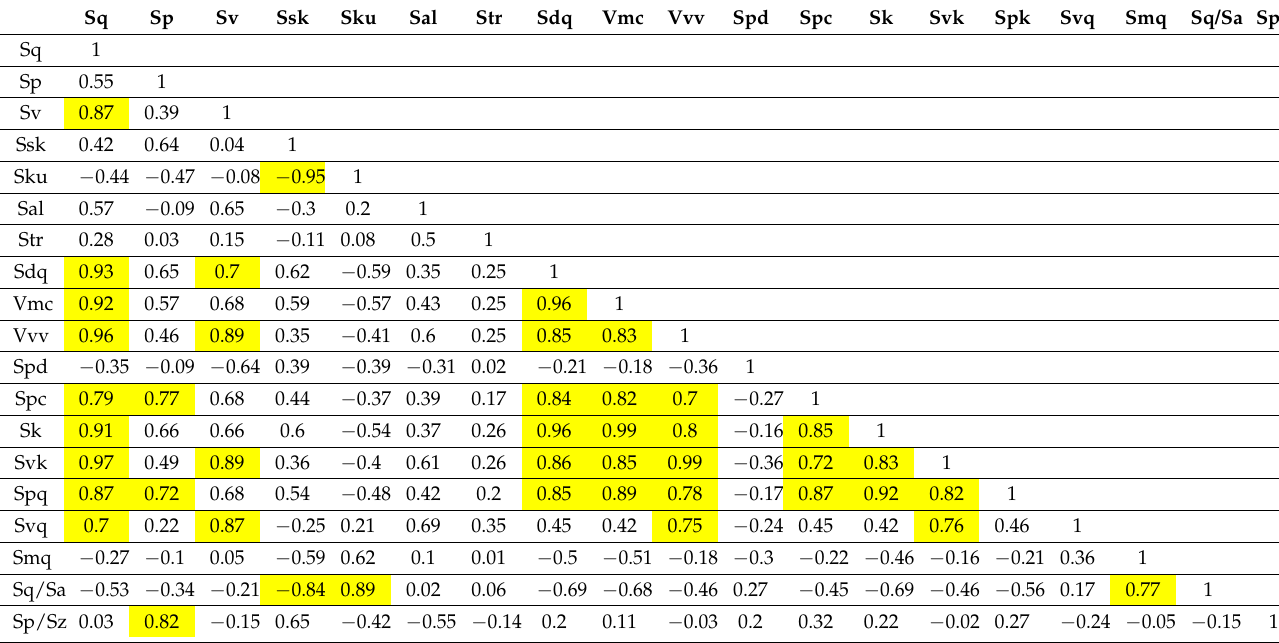
Table 3. Coefficients of linear correlation between selected parameters of surfaces after vapor blasting followed by lapping, the strong correlations are marked by yellow